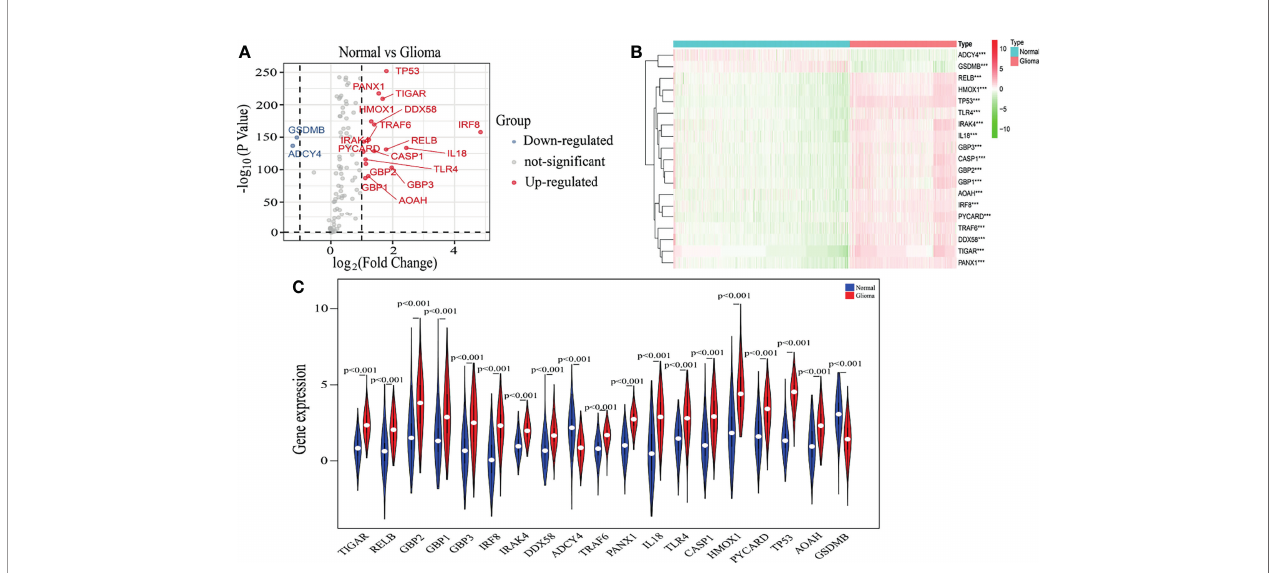
FIGURE 1 | Identi fi cation of pyroptosis-related genes. (A) A volcano plot of 144 differentially expressed pyroptosis-related genes, including nineteen selected genes. (B) The heatmap shows expression levels of nineteen pyroptosis-related genes in normal brain and glioma tissues. *** p < 0.001. (C) The vioplot shows differential expression of nineteen pyroptosis-related genes between normal brain and glioma